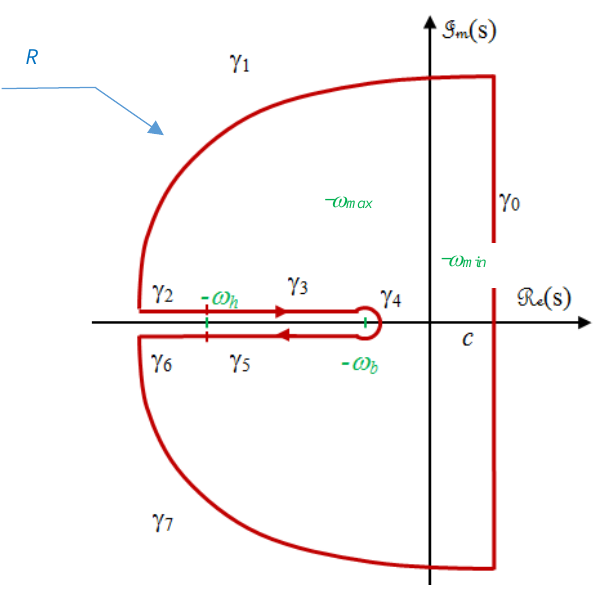
Figure 2. The 𝛤 path considered. Figure 2. The Γ path